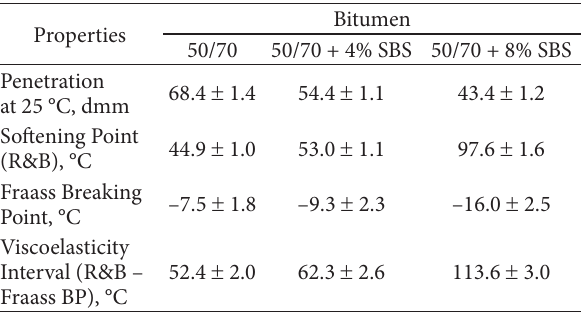
Table 1. Basic properties of the investigated asphalt binders Properties